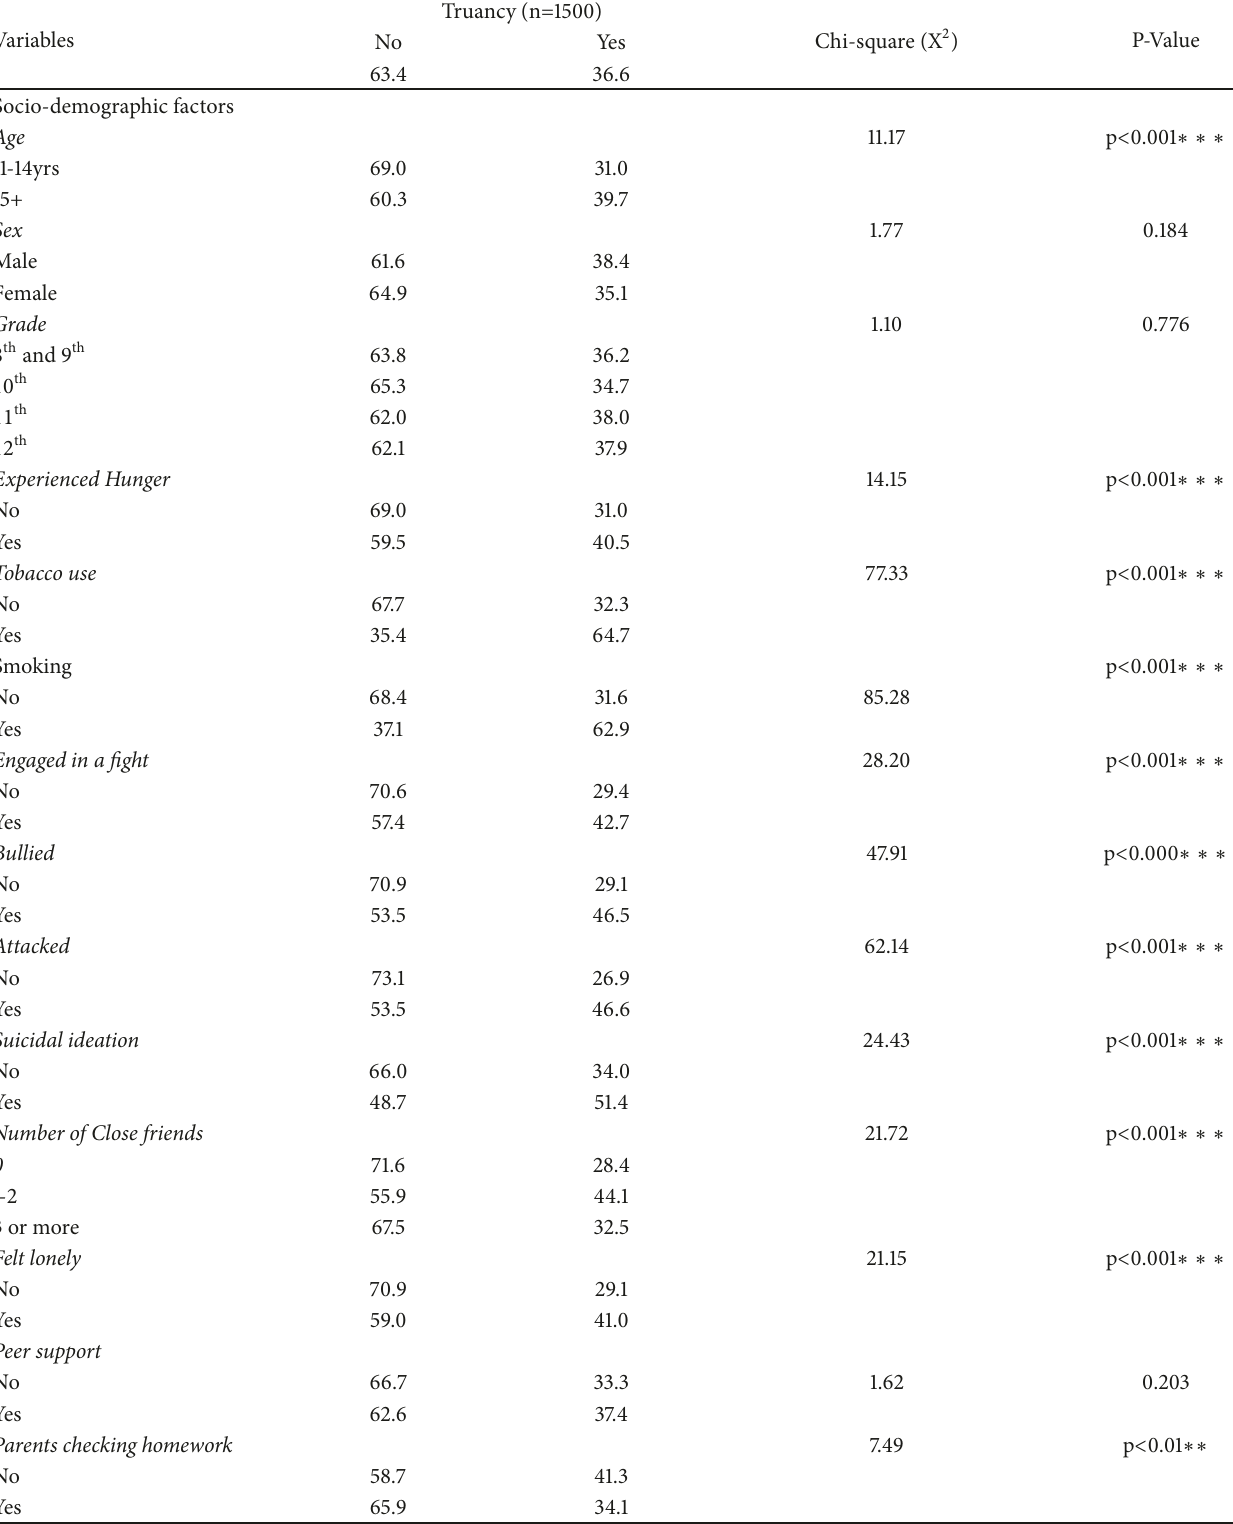
Table 2: Chi-square analysis on the proportions of truancy among in-school adolescents in